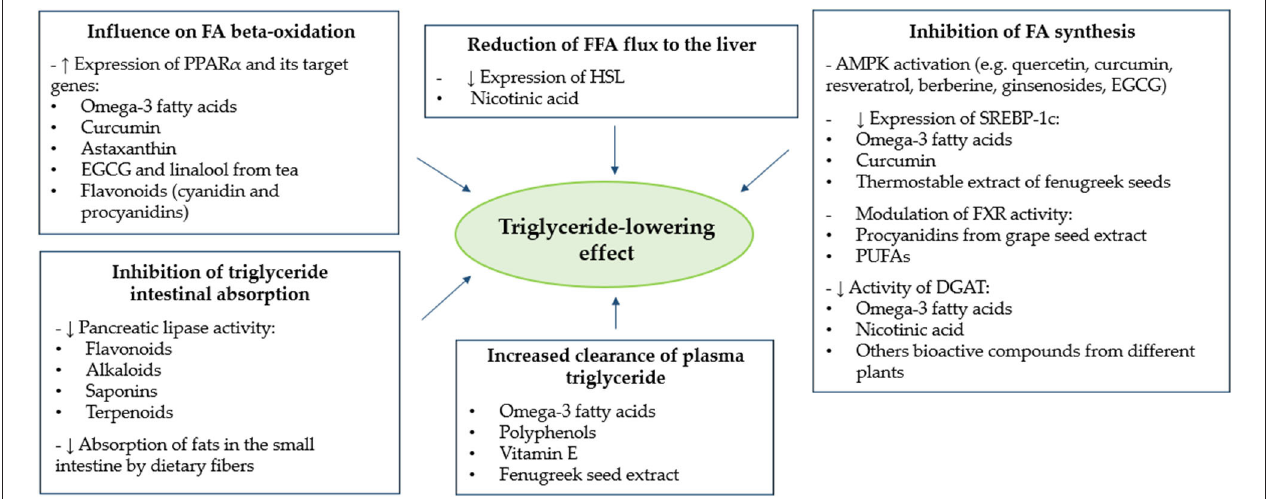
FIGURE 1 | Main putative action targets of different bioactive compounds for the reduction of plasma triglyceride levels. AMPK, adenosine monophosphate-activated protein kinase; DGAT, diacylglycerol O-acyltransferase; EGCG, epigallocatechin-3-gallate; FA, fatty acid; FFA, free fatty acid; FXR, farnesoid X receptor; HSL, hormone-sensitive lipase; PPAR α , peroxisome proliferator-activated receptor alpha; PUFAs, polyunsaturated fatty acids; SREBP-1c, sterol-regulatory-element-binding protein